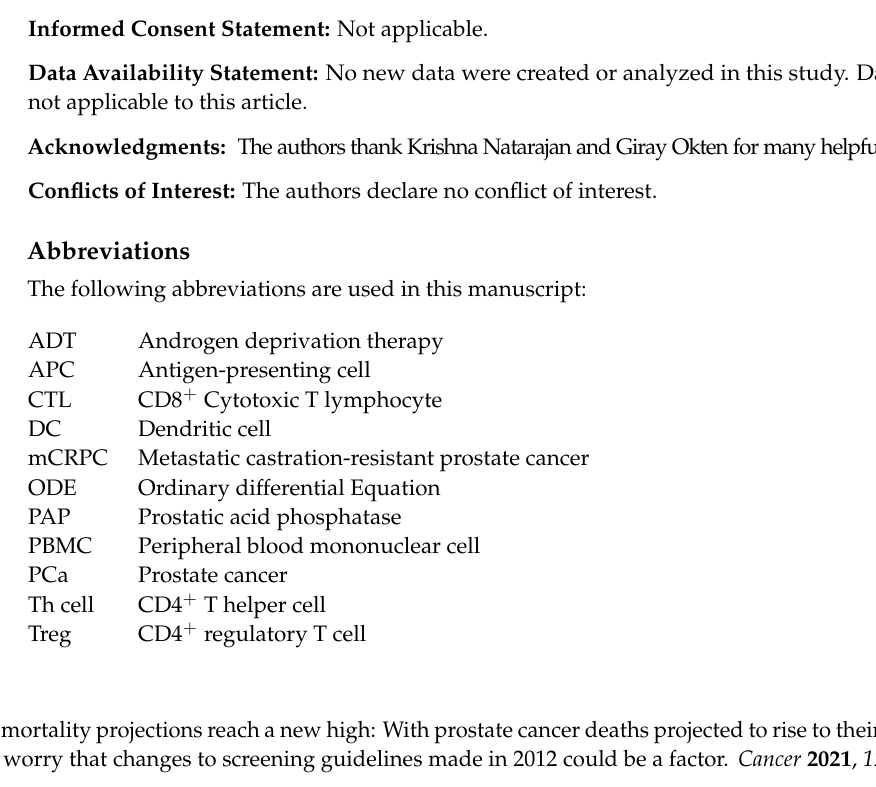
Supplementary Materials: The following are available online at www.mdpi.com/xxx/s1, Table S2.1: Parameter values taken from the literature. Table S2.2: Parameter values taken from the literature. Table S2.3: Parameter values fit to experimental data. Table S2.4: Additional parameter values. Table S2.5: 95%confidence bounds on sampled parameters. Table S3.1: Model parameters significantly associated with cure under optimized combination therapy. Figure S2.1: Posterior distributions of parameters relating to immune presence in the tumor inferred using a sample importance resampling algorithm. Figure S2.2: Posterior distributions of parameters relating to tumor growth and response to ADT inferred using a sample importance resampling algorithm. Figure S2.3: Assumed distribution of K I , the CTL to target cell ratio at which rate of CTL-induced cell kill is half its maximum